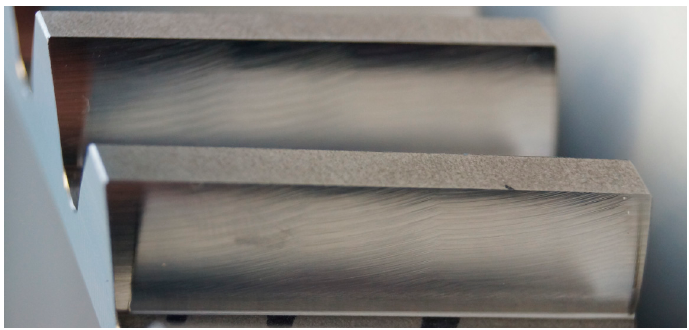
Figure 16. Quality of the hard machined test gear (with inserts of type 1010), lateral view on the gear flank.